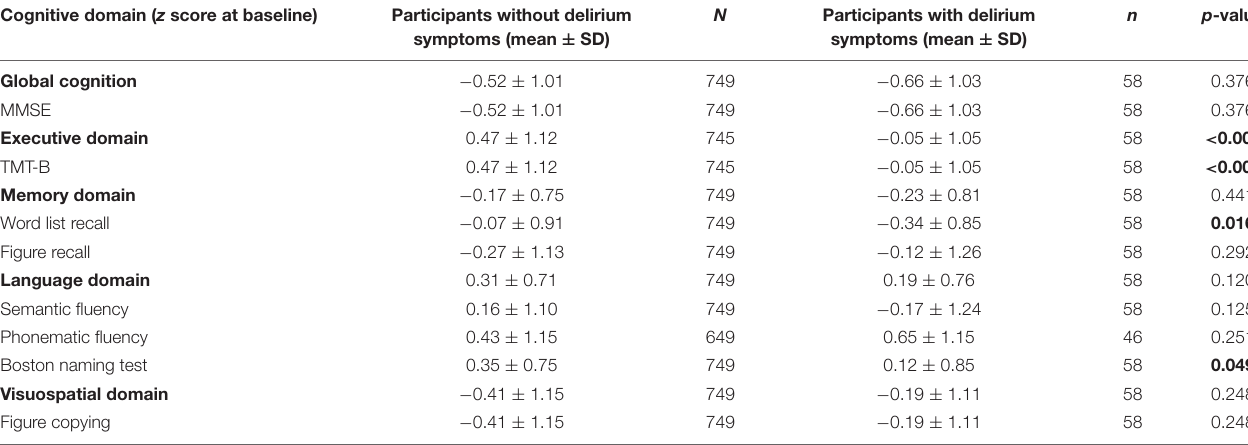
TABLE 2 | Cognitive characteristics from participants with and without delirium symptoms according to the CERAD-Plus test battery at baseline, z scores. Cognitive domain ( z score at baseline)